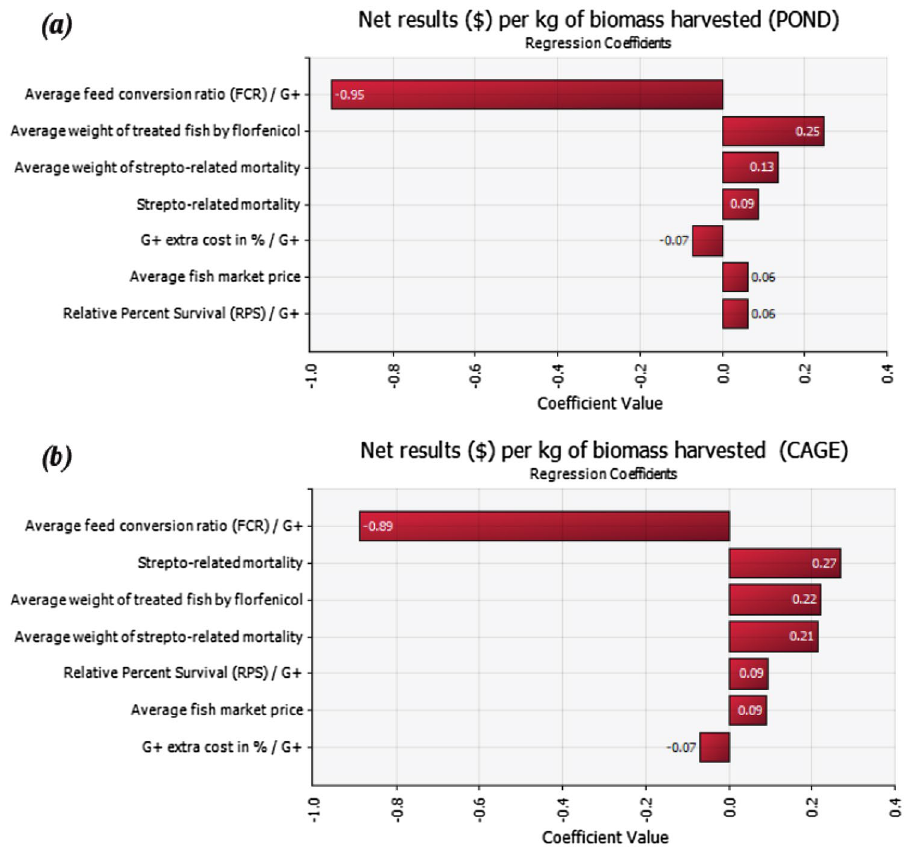
Figure 2. Regression sensitivity (tornado plot) for variables modelled with Pert distributions for the ( a ) pond scenario and ( b ) cage scenario. G+ indicates genetically selected Nile tilapia fingerlings resistant to